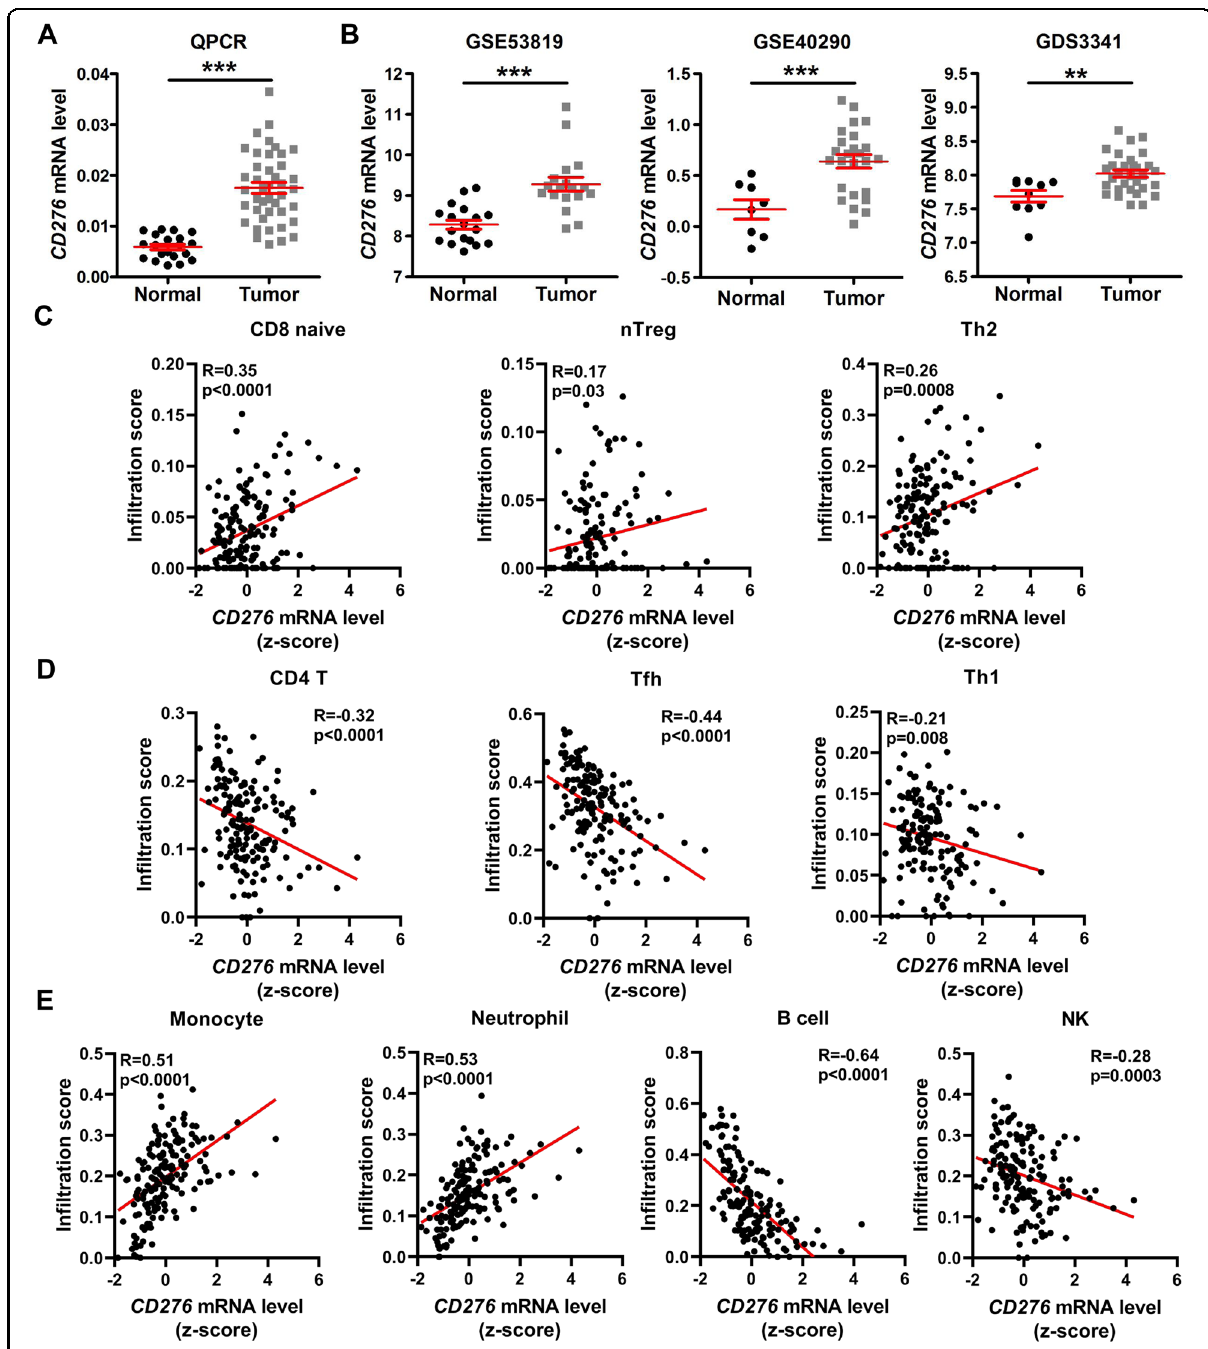
Fig. 5 CD276 is upregulated and associated with immune in fi ltration in NPC. A The graphs show that CD276 is signi fi cantly upregulated in NPC samples ( n = 41) compared to normal samples ( n = 20) via qPCR analysis. *** P <0.001 was determined by Student ’ s t test. B The graphs show that CD276 is signi fi cantly upregulated in NPC samples compared to normal samples, as indicated by four public datasets from GEO (Gene Expression Omnibus database). ** P <0.01, *** P <0.001 was determined by Student ’ s t test. C Correlation analysis between the CD276 mRNA level and the tumor-promotion T-cell subset in fi ltration, including CD8-naive cell (left), nTreg cell (middle), and Th2 cell using publicly available NPC RNA-seq data. A Pearson correlation test was used (two- tailed). D Correlation analysis between the CD276 mRNA level and the tumor-repression T-cell subset in fi ltration, including CD4 T cell (left), Tfh cell (middle), and Th1 cell using publicly available NPC RNA-seq data. A Pearson correlation test was used (two-tailed). E Correlation analysis between the CD276 mRNA level and the in fi ltration level of monocyte, neutrophil, NK, and B cells using publicly available NPC RNA-seq data. A Pearson correlation test was used